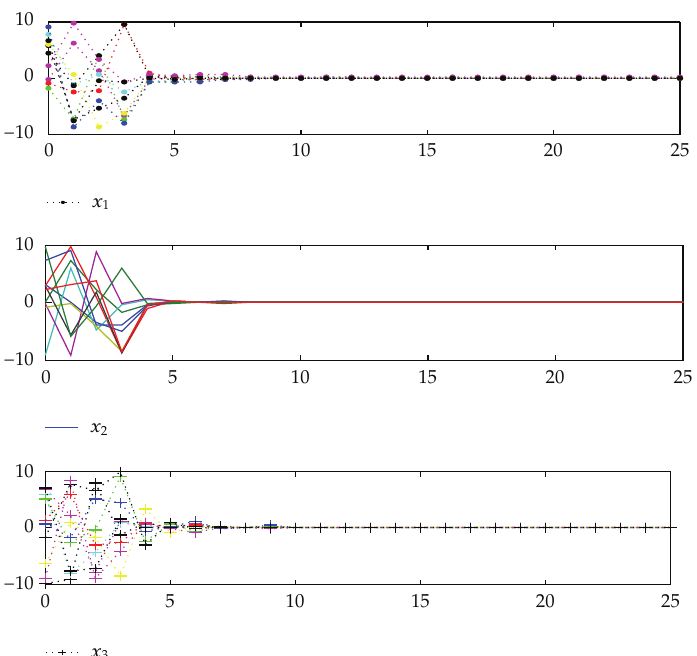
Figure 2: Global convergence of states x 1 , x 2 , and x 3 in Example 4.2, when d 1 (cid:7) 1 and d 2 (cid:7)